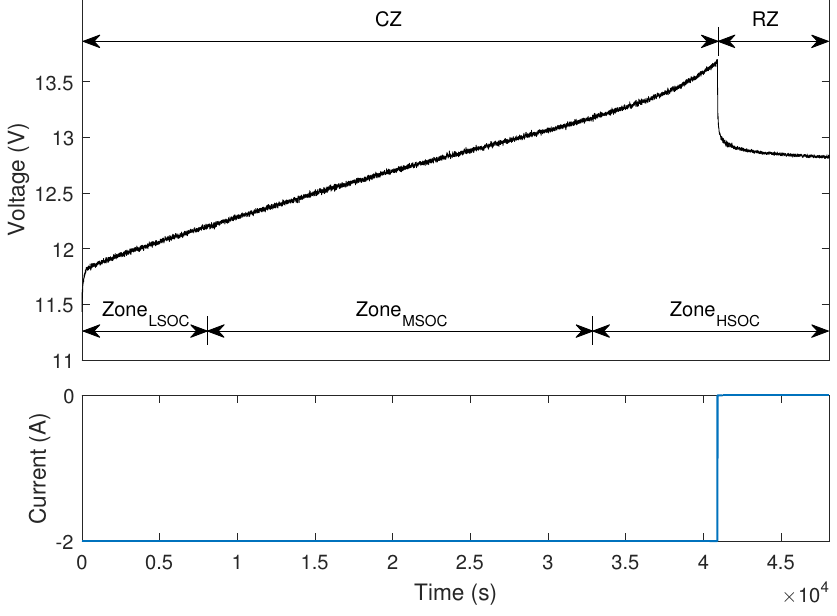
Figure 4. Battery charge response in test 4 ( I = I c 1 = − 2 A). RZ corresponds to the time interval when the current was zero, and CZ (charge zone) is the remaining time interval (charge time). Zone HSOC , Zone MSOC and Zone LSOC are the zones at high, medium and low SOCs, respectively.